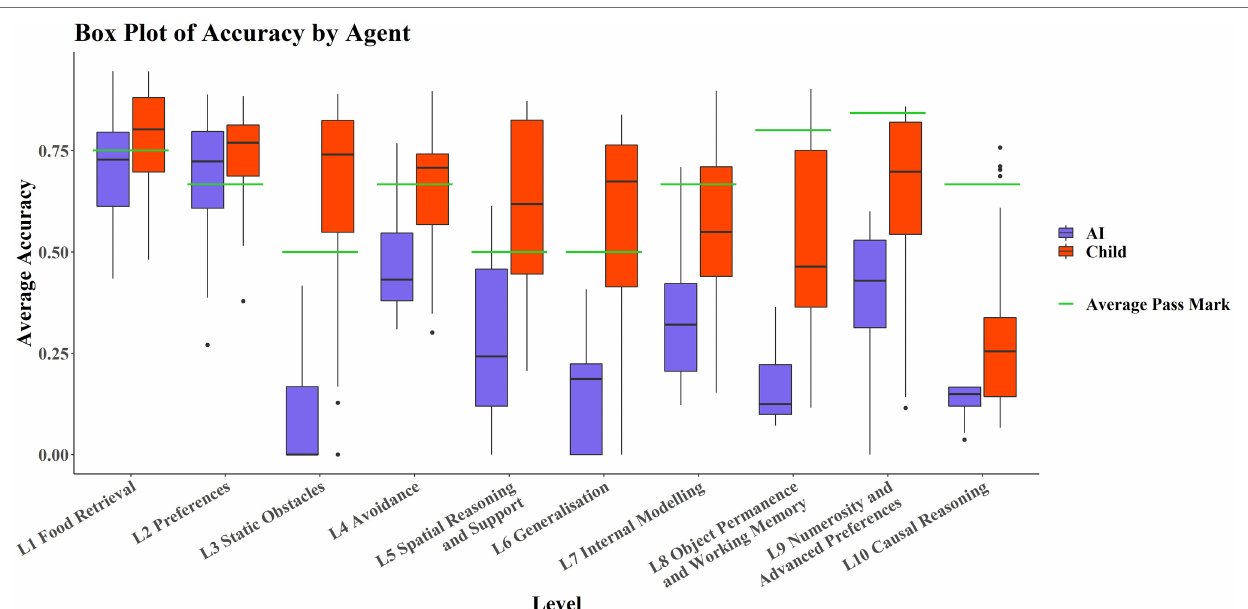
FIGURE 3 | Boxplots by level and by agent. Levels are in ascending order on the x-axis, with AIs in purple (left hand boxplot of each pair) and children in red (right hand boxplot of each pair). Average pass marks for each level are shown in